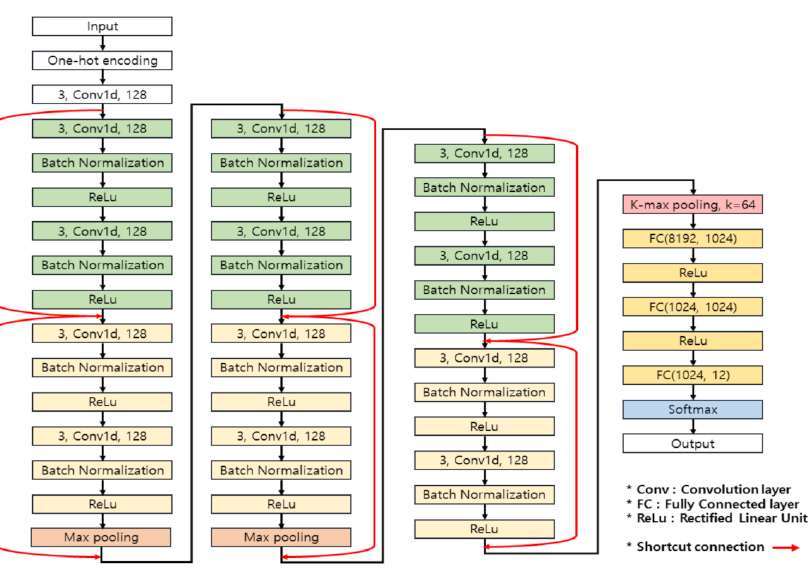
Figure 12. Structure of the character convolution neural network applied in this